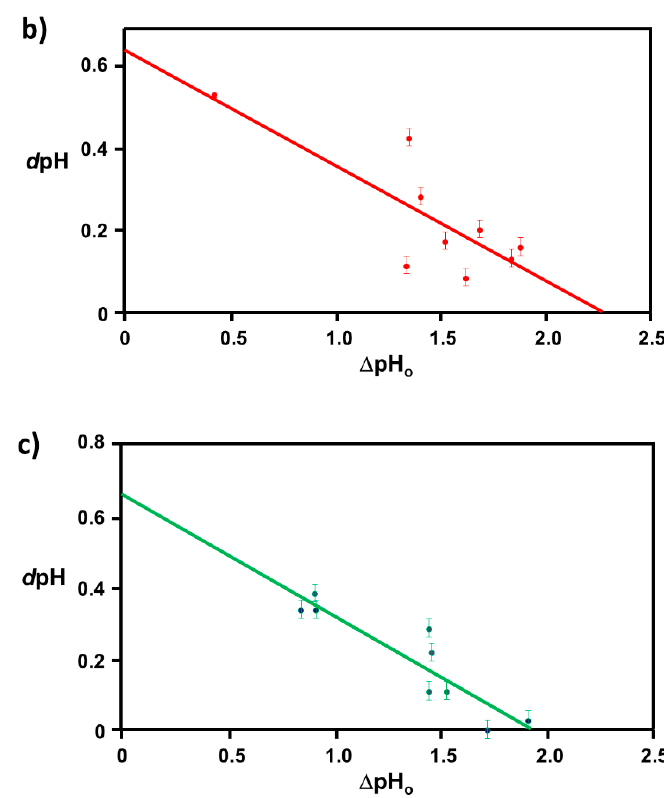
Figure 1. A hypothesized linear relationship between d pH vs. ∆ pH o was plotted for each amyloidogenic peptide-coated nano gold colloid, ( a ). A β 1–40 in blue, ( b ). α -syn in red, and ( c ). β 2m in green based on the values obtained from fitting sigmoidal plot with Equation (1). Each linear line was given as a guide for a correlation between d pH vs. ∆ pH o . ( d pH = m ∆ pH o + b). Supporting information of this figure is available at www.mdpi/xxx/s1.